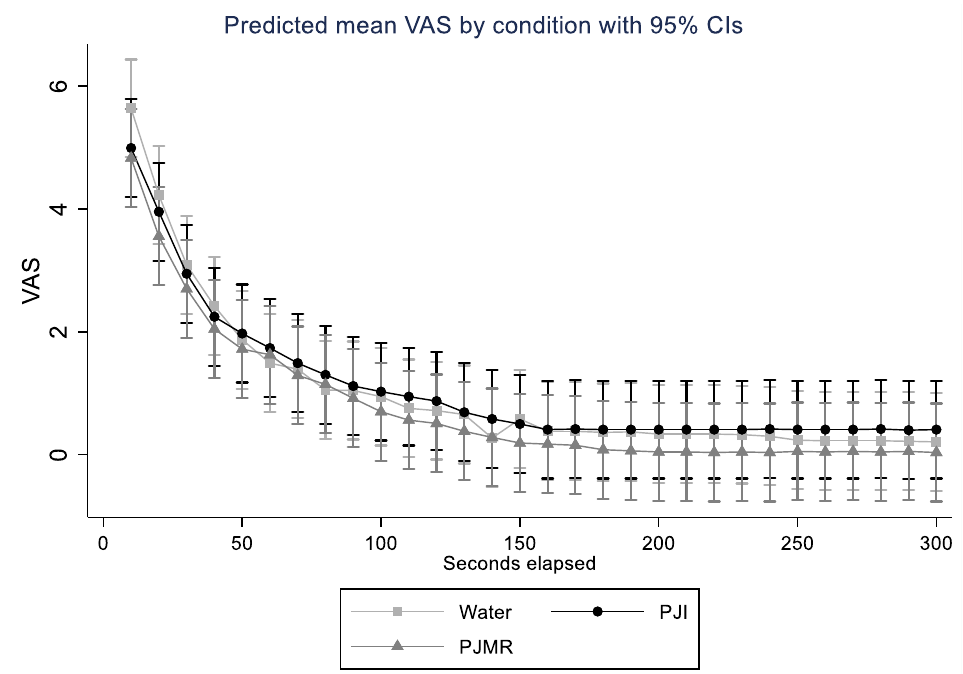
Figure 2. Linear mixed models with random subject intercepts comparing visual analogue scale (VAS) between conditions over time (seconds).